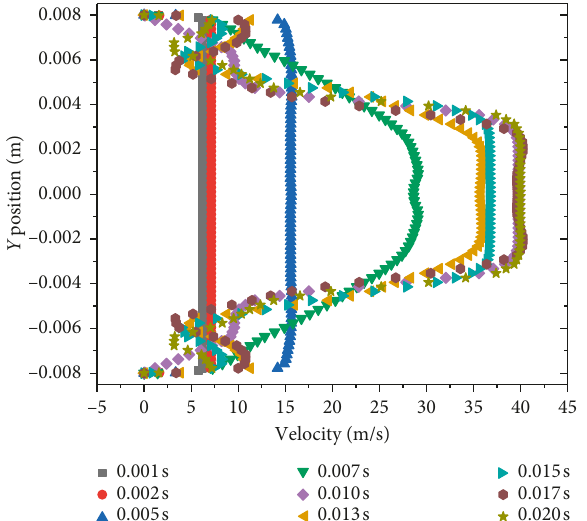
14: Relationship between velocity and time.